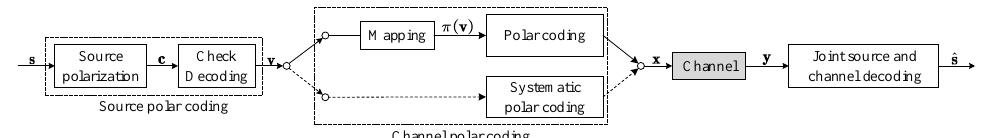
Figure 1. The JSCC framework based on the polar